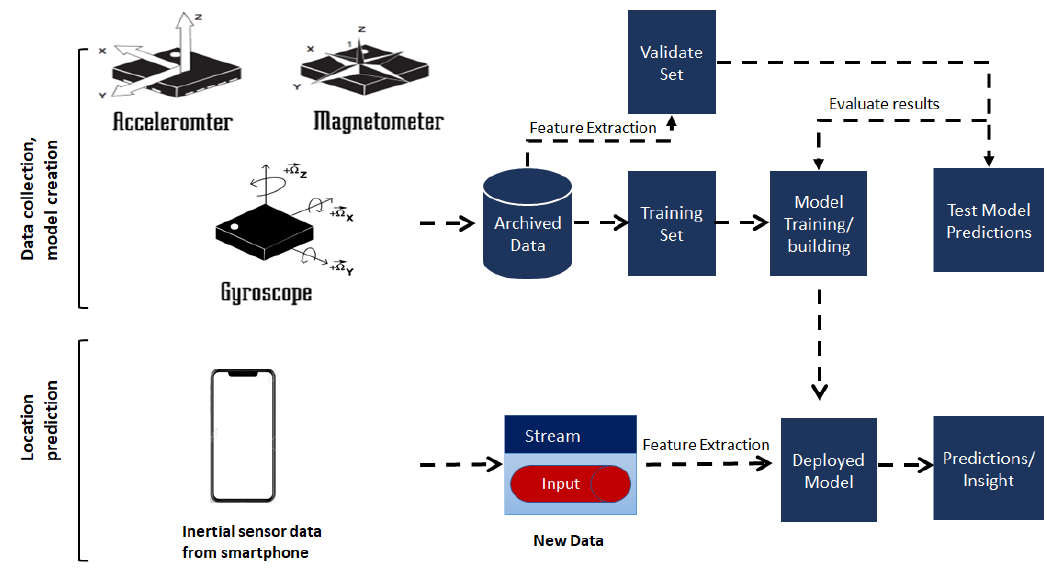
Figure 8. Experimental platform for the proposed model.